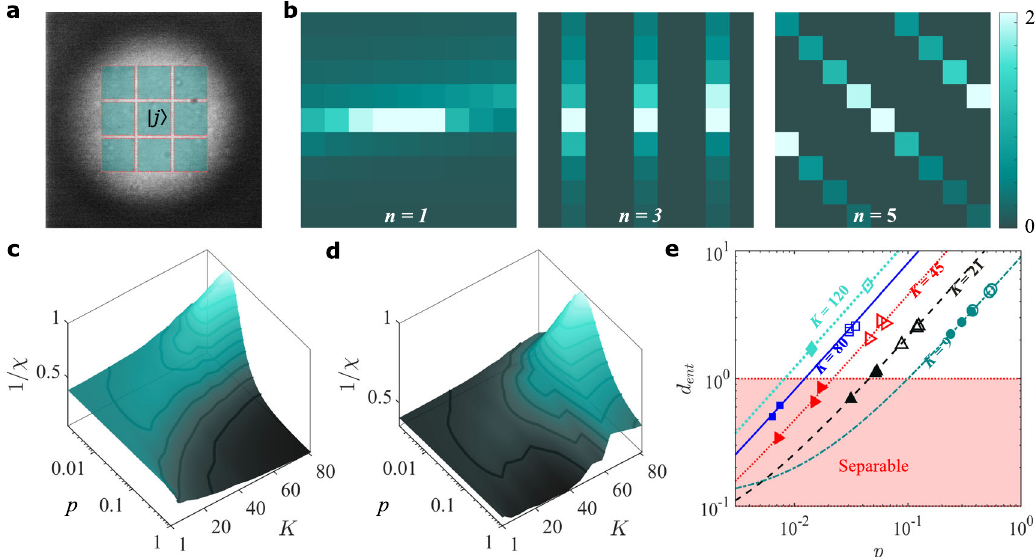
Fig. 4 Demonstration using the pixel basis. a The basis of our entanglement is expressed as pixels, illustrated here across the SPDC source (measured at the crystal), where each pixel is our state, j j i . b Example holograms in this basis for the visibility measurements, shown here for n = 1, 3 and 5. c , d show the measurement outcomes for two example cases of dimension and purity, with and without background subtraction, respectively. All the measurements outcomes are plotted as data points in ( e ) showing the Schmidt rank, d ent as a function of purity, p , in excellent agreement with theory (lines). The dimensionality, K , is quoted for each case. Error bars are too small to be